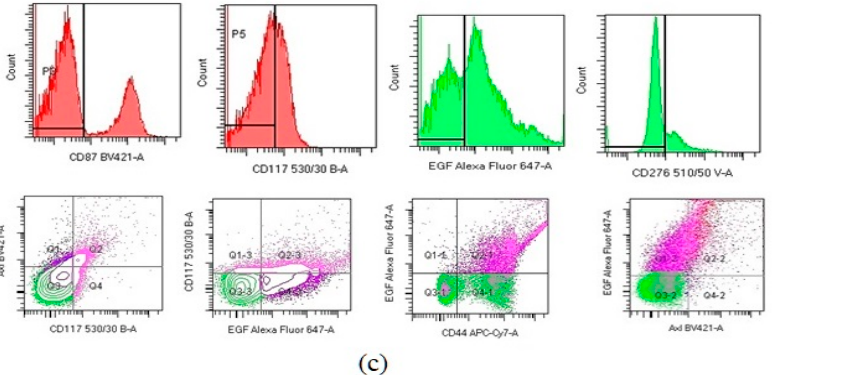
Figure 1. Characterization of circulating tumor cells (CTCs) isolated from the blood of patients with small cell lung cancer (SCLS) and healthy volunteers. Cells were analyzed by flow cytometry using antibodies against CD87, CD117, CD276, CD44, Axl, and EGF. ( a ) Levels of CD87 + , CD87 + CD117 + , CD117 + Axl + EGF + CD44 + , EGF + Axl + , CD117 + EGF + , Axl + CD117 + EGF + , CD276 + , CD276 + CD117 + , CD87 + CD276 + , and EGF + Axl − CTCs in the blood of patients with SCLC and healthy volunteers (% of all labelled mononuclear cells); ( b ) phenotype establishment and qualitative analysis of CD44 (APC-H7), CD117 (BB515), CD87 (BV421), CD276 (BV510), EGF(AF647), and Axl (BV421) expression in blood of healthy volunteers; (c) phenotype establishment and qualitative analysis of CD44 (APC- H7), CD117 (BB515), CD87 (BV421), CD276 (BV510), EGF(AF647), and Axl (BV421) expression in blood of patients with SCLS. * Differences are significant in comparison with volunteers ( p < 0.05). Moreover, the number of ALDH + cells was increased in the blood of patients with SCLC. However, differences between the individual groups were not significant (Figure 2).